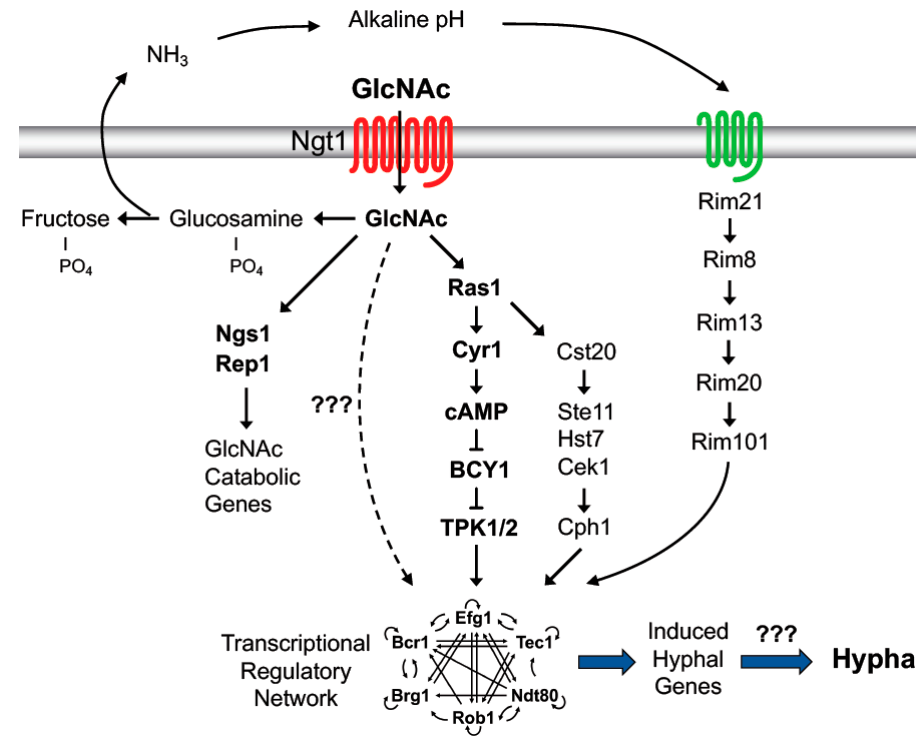
Figure 3. Signal transduction pathways activated by GlcNAc. GlcNAc induces a pathway that acts through the Ngs1 and Rep1 transcription factors to induce the GlcNAc catabolic genes. It also induces a cAMP-independent pathway to stimulate hyphal growth (dashed line). These pathways do not require metabolism of GlcNAc. However, if GlcNAc is catabolized it makes the extracellular environment more alkaline, which activates signaling through the Rim101 pathway that synergizes with GlcNAc to stimulate hyphal morphogenesis and gene induction. The wavy green line in the plasma membrane indicates the pH sensing complex. Lines with an arrowhead indicate activation and lines with a blunt tip indicate negative regulation.